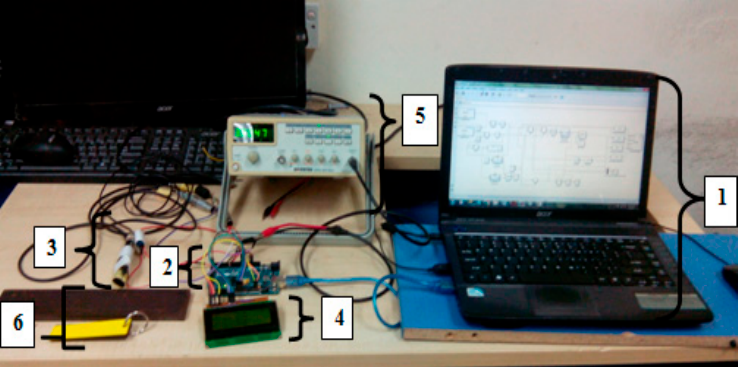
Figure 8. SFECT System Components Setup. 1: Computer; 2: ATMEGA 2560 microcontroller; 3: Absolute and Differential probe combining; 4: LCD display; 5: Function generator; 6: Calibration block.